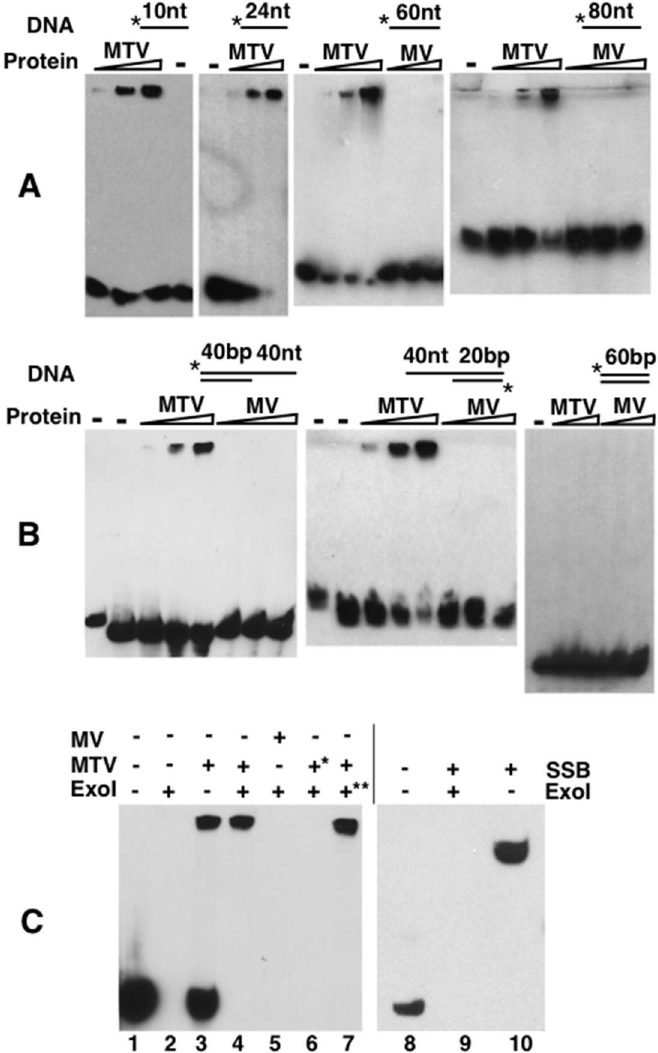
Fig 4. MTV binds and protects ssDNA. A : MTV but not MV binds ssDNA. Increasing amount of MTV or MV were mixed with 5’-labelled oligos ( * ). The oligo is shown as a line with size indicatedon top. B : MTV binds single stranded overhangs of dsDNA. The overhangs are indicatedon top of each image with the size of the doublestranded and single stranded regions indicatedon top of the doubleline. Free single stranded oligos with the 5’-end label were loadedin the first lanes of the left and middleimages. In the second lane of these images, the annealed products of the two oligos were loadedand ran. C : MTV, not MV or bacterial SSB, protects ssDNA from bacterial ExoI. For lanes 4 and 6, MTV and ExoI were mixed sequentially with the oligos. But for lane 6 ( * ), MTV was first boiled for 5 minutes before mixing. For lane 7 ( ** ), MTV and ExoI were first mixed then added to the bindingreaction with the